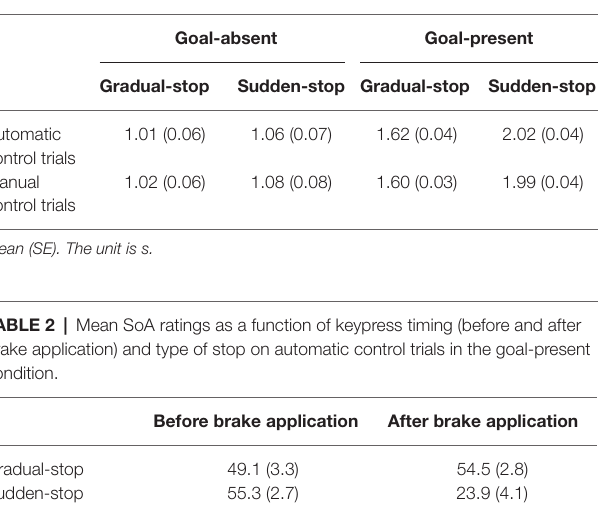
TABLE 1 | Mean elapsed times from trial onset to participant